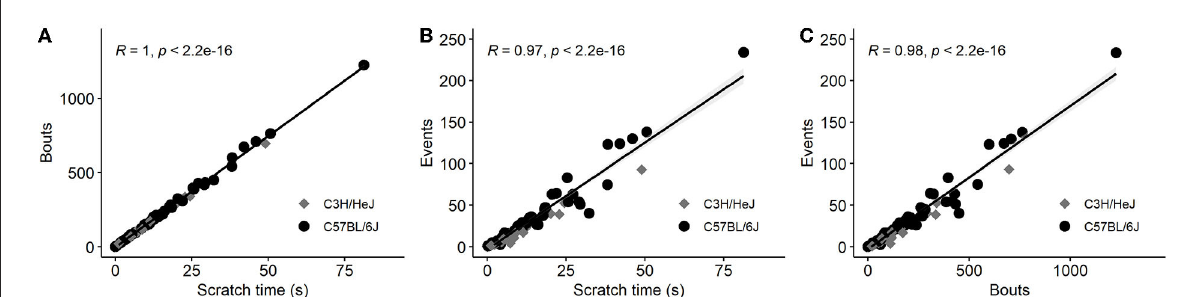
FIGURE1 Pearson correlation matrix of scratching time, scratch bouts, and scratch events summarizing all data points from a one-fold concentration of each pruritogen in C3H and C57 mice. Pruritogens were injected into the nape of the neck, scratch behavior was measured immediately for 30min and values were summed. Scratch time represents the cumulative time in s, scratch bouts were counted as the number of uninterrupted scratch movements in a 30min test period and the scratch events consisted of several scratch bouts from the moment of one paw lift until the paw was let down. All three parameters were recorded independently by the software for every mouse and correlated with each other. (A,B) Illustrate the correlation of scratch time with scratch bouts and scratch events, and (C) the correlation of scratch bouts with scratch events. Each point represents data from one individual mouse. All parameters are highly correlated ( n =